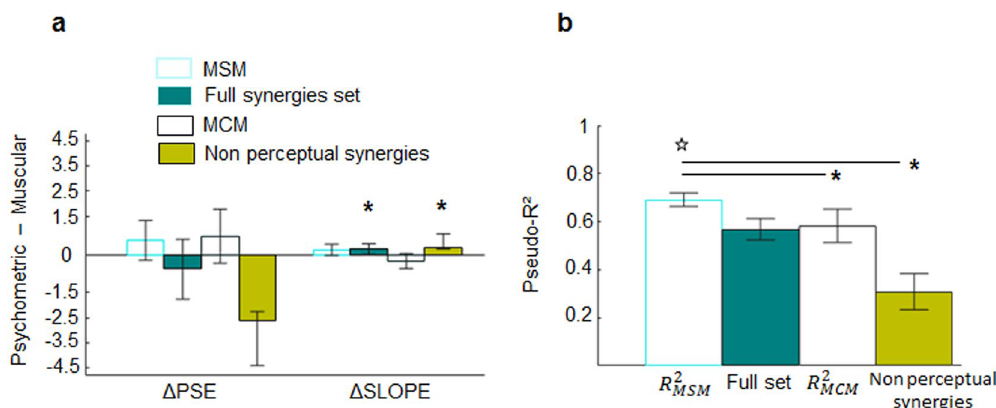
Figure 4. Comparison of muscle models. ( a ) Δ PSE and Δ SLOPE medians ± SE (n = 10) extracted from the comparison between the parameters describing the psychometric curve and the curve predicted by MSM (cyan empty bar), the full set of synergies (green), MCM (black empty bars). and the subset composed of non-perceptual synergies (light green). Distribution of Δ Slope and Δ PSE were submitted to one sample Wilcoxon one-tailed test to assess whether medians were significantly different from 0 (p < 0.05). ( b ) Efron pseudo-R² medians ± SE (n = 10) describe the amount of perceptual variance, i.e., P( yes ), accounted for by the curves derived from MSM, MCM, full set of synergies and non-perceptual synergy subset (color code as in a ). Statistically significant differences across pseudo-R² values were tested through a non-parametric Friedman ANOVA. Post-hoc tests were conducted by applying Bonferroni correction, * indicating p < 0.008. Star denotes the one-tailed Wilcoxon non-parametric test assessing models’ pseudo-R² medians significantly higher than